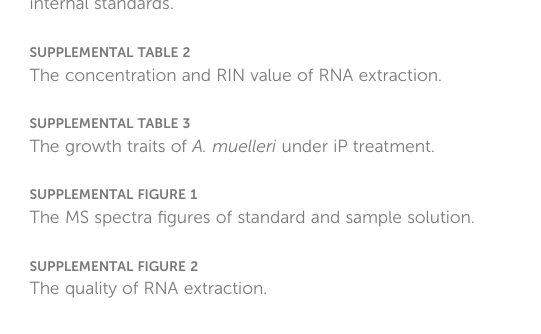
SUPPLEMENTAL FIGURE 2 The quality of RNA